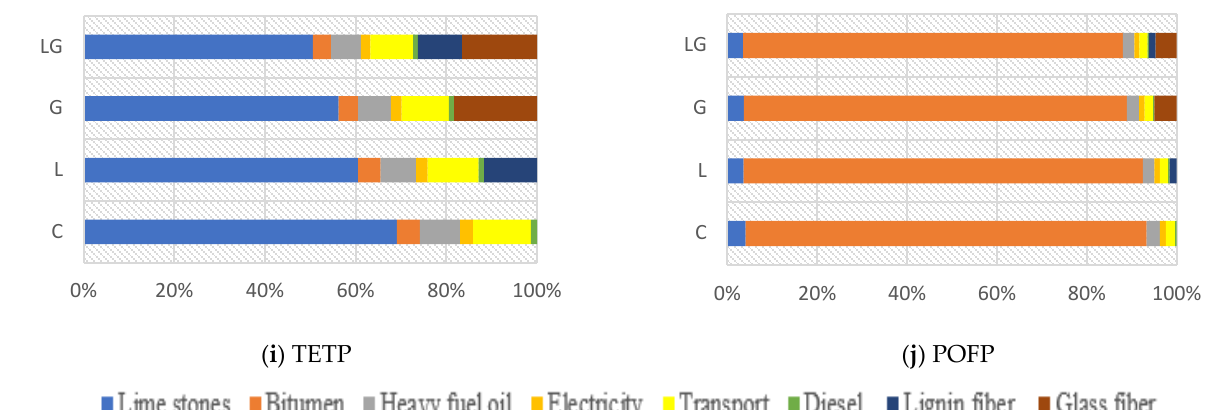
Figure 5. Relative contribution of the main processes to the total impact scores: ( a ) ADP; ( b ) AP; ( c ) EP; ( d ) GWP; ( e ) OLD;